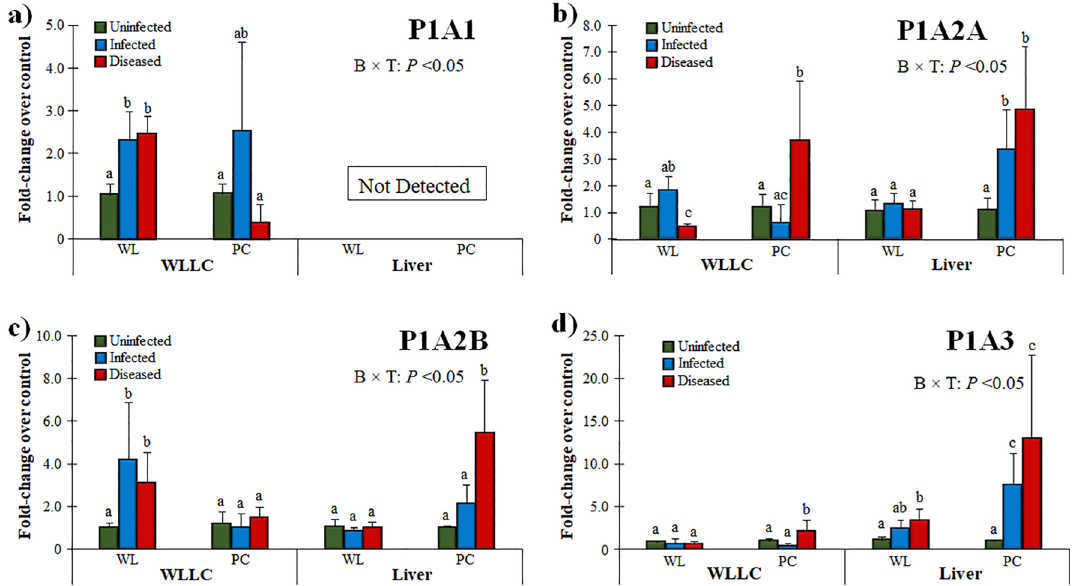
Figure 3. Relative mRNA expression of P1 PRs in the MD-resistant (WL) and -susceptible (PC) chicken lines. PR expression was measured in WLLC and liver samples using RT-qPCR and fold-changes compared (B) × Infection (T)]. Superscripts a-c indicates significant differences ( P < 0.05) between different groups in specific tissues (WLLCS or Liver) of the two chicken